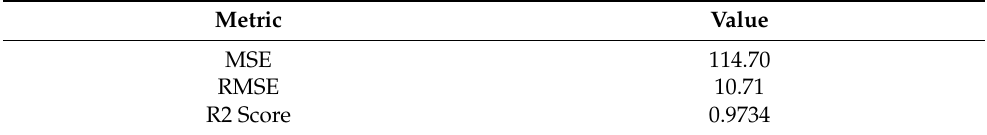
Table 5. RUL prediction CNN model accuracy